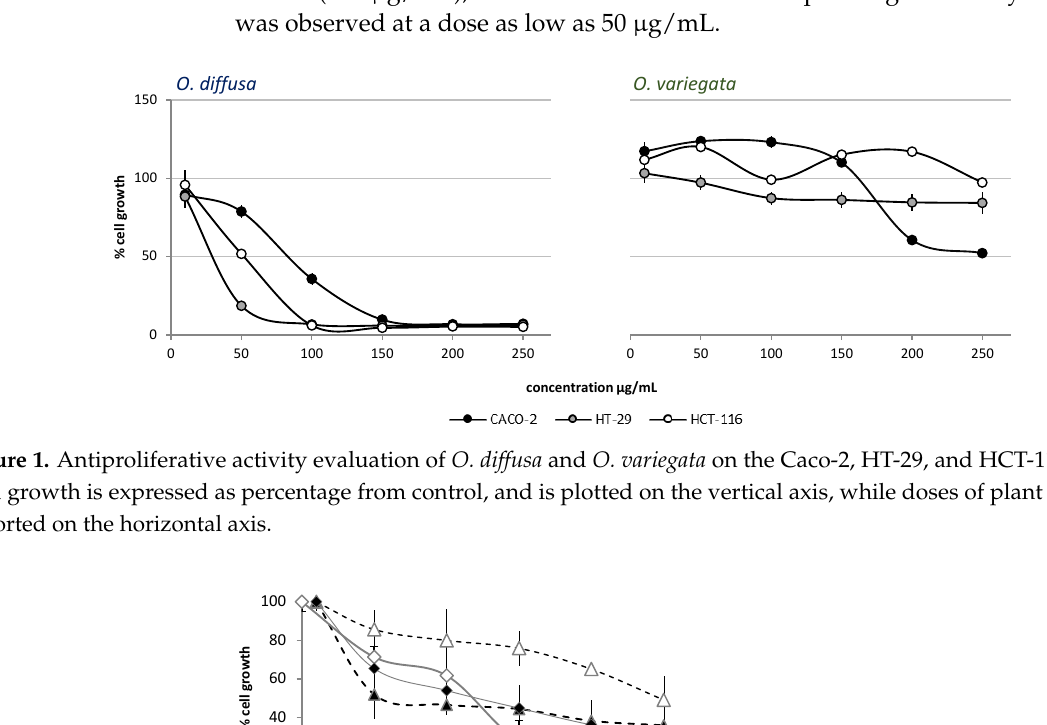
Figure 2. Antiproliferative activity evaluation of O. diffusa against the SW48, SW48-CR, GEO, and GEO-CR cell lines. Cell growth is expressed as percentage from control, and it is plotted on the vertical axis, while doses of plant extracts are reported on the horizontal axis.